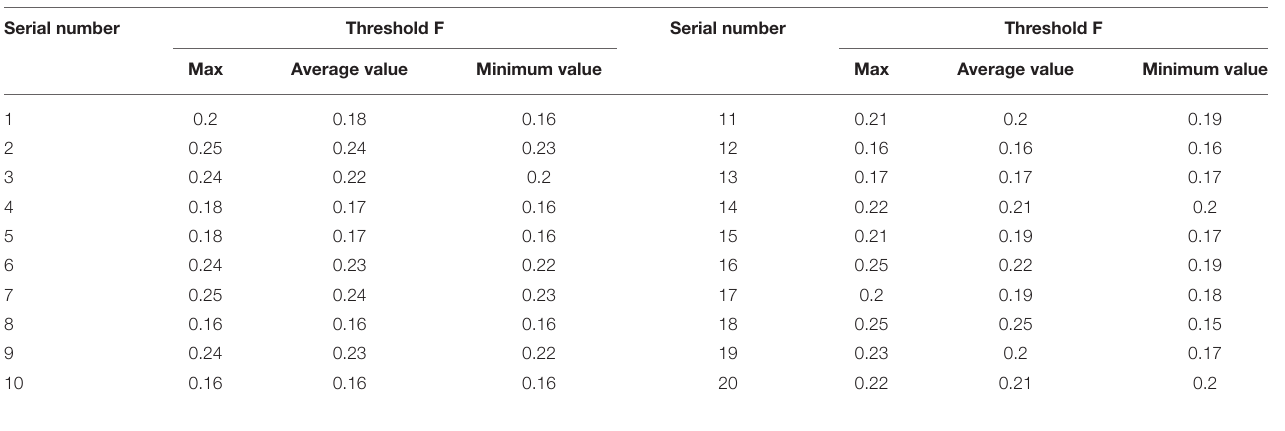
TABLE 1 | Threshold statistics of seedings.